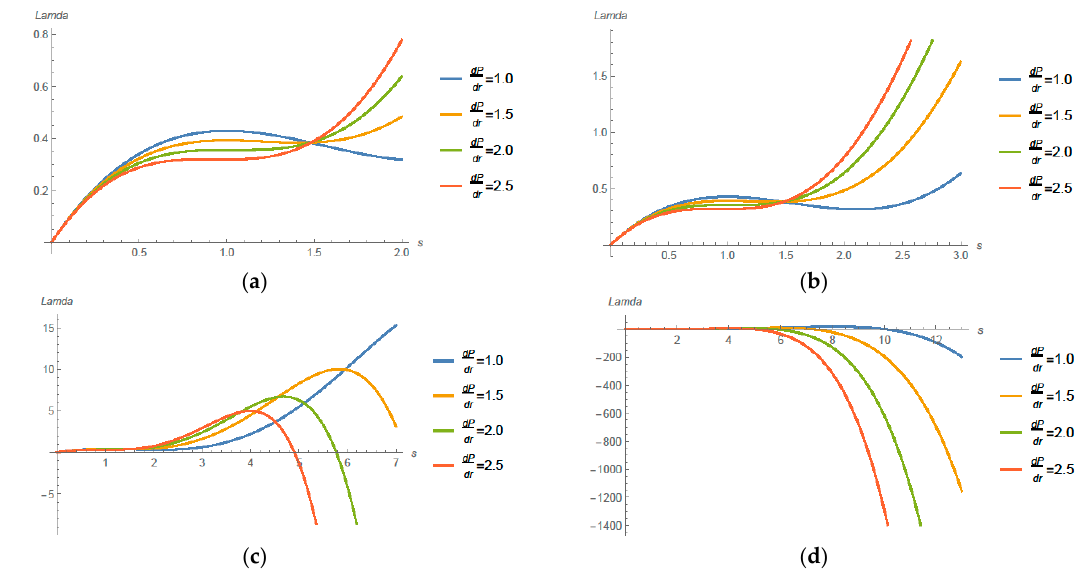
Figure 4. λ at different values of 𝑃 (cid:3045) = (cid:2914)(cid:3017)